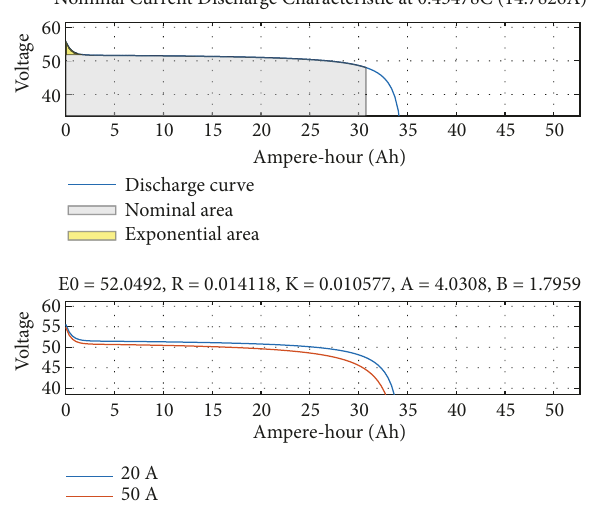
Table 4: Battery model input parameters.